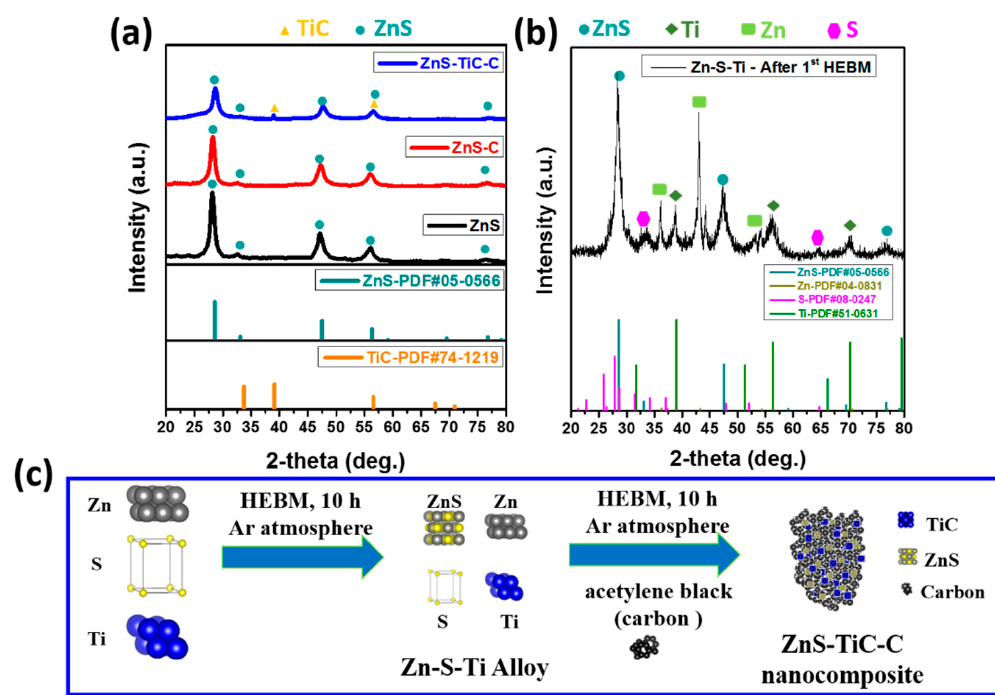
Figure 1. XRD patterns for ( a ) the ZnS, ZnS-C, and ZnS-TiC-C composites, ( b ) the Zn-S-Ti alloy after the first high-energy ball-milling (HEBM) process; and ( c ) schematic of the synthesis of the ZnS-TiC-C composite.